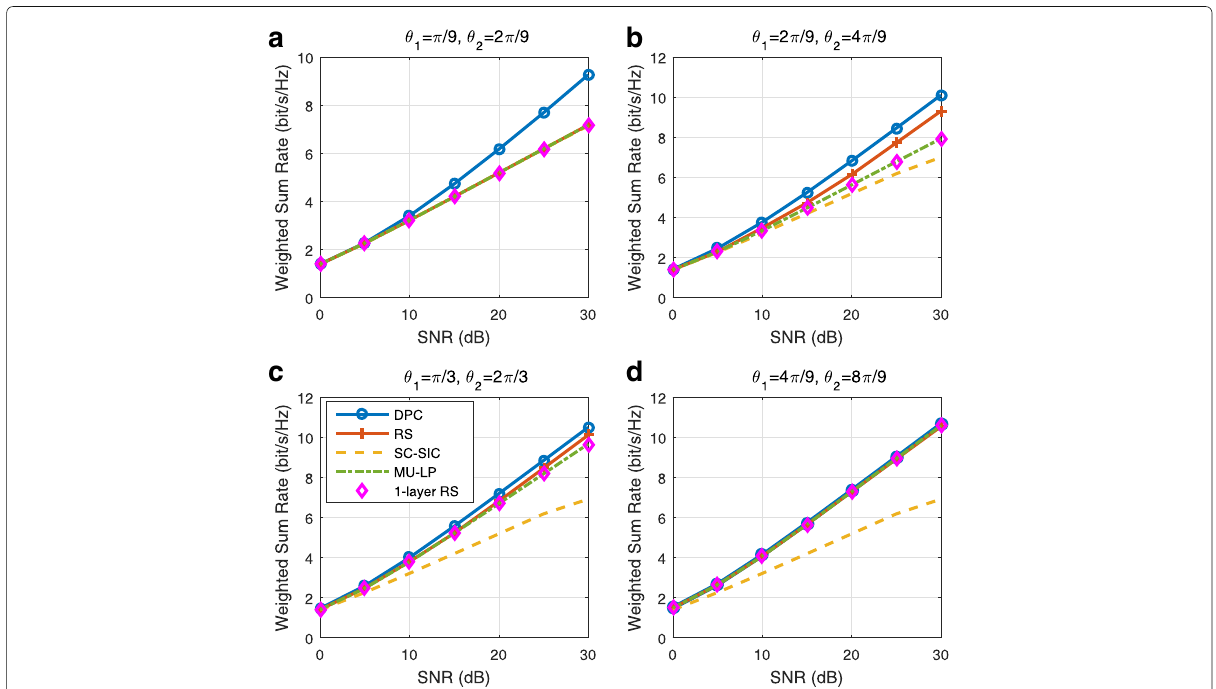
Fig. 34 Weighted sum rate versus SNR comparison of different strategies for underloaded three-user deployment with perfect CSIT, γ 1 = γ 2 = 1,